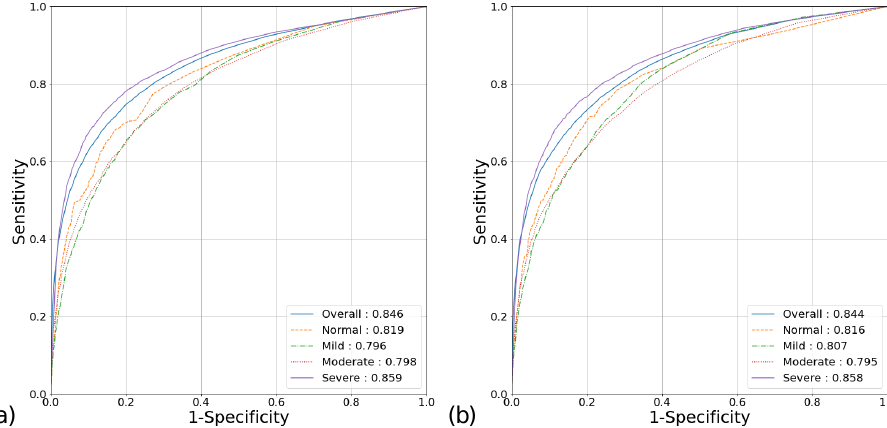
Figure 5. ROC analysis of per-segment classification for the ( a ) binary and ( b ) multiclass